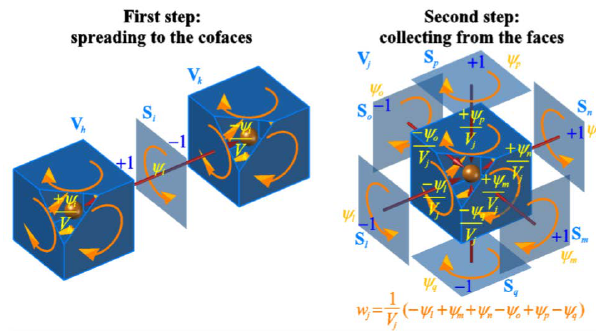
Figure 25: The coboundary process on a discrete 2-form defined on the surfaces of a space cell